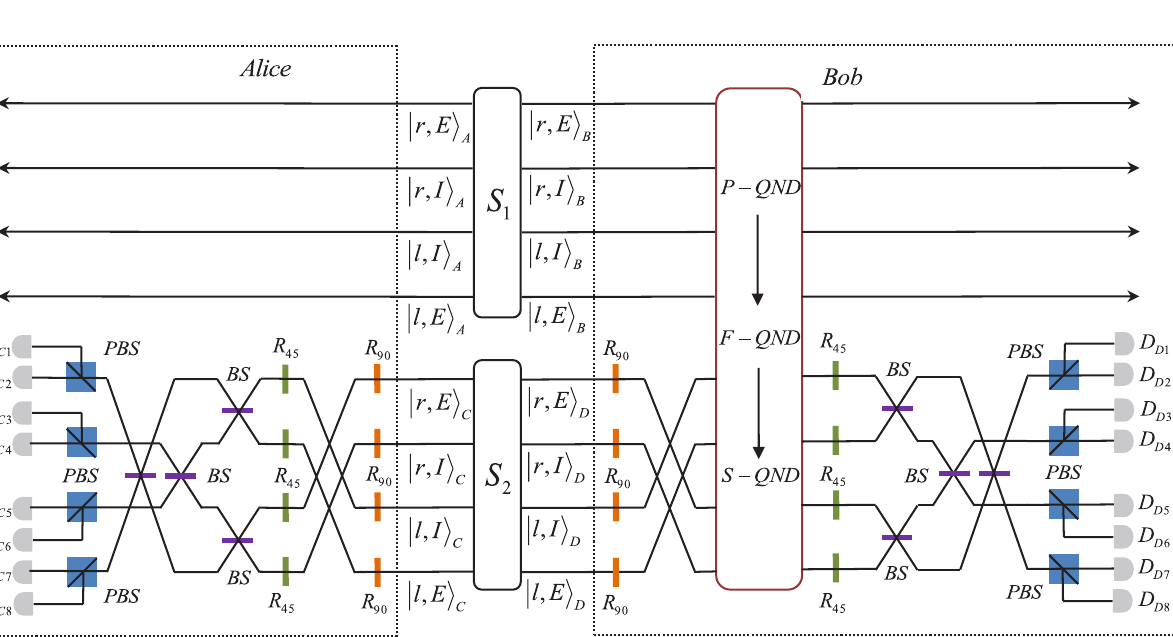
θ of the coherent state. ±